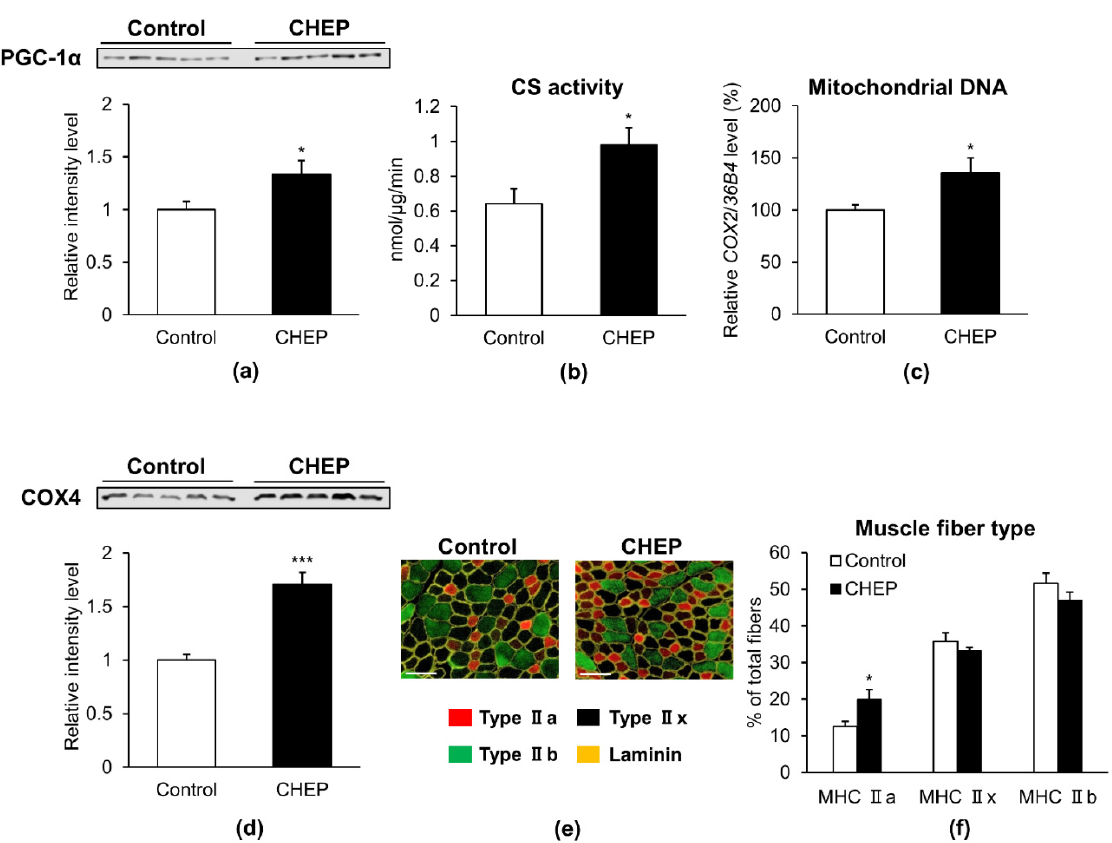
Figure 2. CHEP increases the amount of PGC-1 α protein, mitochondria, and oxidative fibers in murine skeletal muscle. Seven-week-old male C57BL/6J mice were treated with an HC diet (control) or an HC diet containing 0.25% ( w / w ) CHEP for 5 weeks. Protein expression levels of PGC-1 α ( a ) and COX4 ( d ) in the gastrocnemius were evaluated using western blotting. Total PGC-1 α and COX4 protein levels were normalized to the total protein amount on the membrane, obtained after Ponceau S staining. Relative protein levels were expressed compared to those of the control. ( b ) CS activity in the gastrocnemius was normalized to protein content in the homogenate. ( c ) Mitochondrial DNA content in the gastrocnemius is expressed as a percentage relative that in control. Relative mitochondrial DNA copy number was calculated as the ratio of COX2 (mitochondrial) to 36B4 (nuclear) gene expression level, using real-time PCR. ( e ) Representative images of TA stained with anti-MHC type IIa (red), type IIb (green), and laminin (yellow) antibodies. Unlabeled fibers (black) are MHC IIx fibers. There are no MHC I (blue) fibers in this section. Scale bar: 100 µ m. ( f ) Percentage of muscle fiber types in TA. Muscle fibers were counted in all cross sections based on immunofluorescence staining. Values are expressed as mean ± SEM ( n = 5); * p < 0.05, *** p < 0.001 vs. control. HC, high carbohydrate; COX4, cytochrome c oxidase subunit IV; TA, tibialis anterior; MHC, myosin heavy